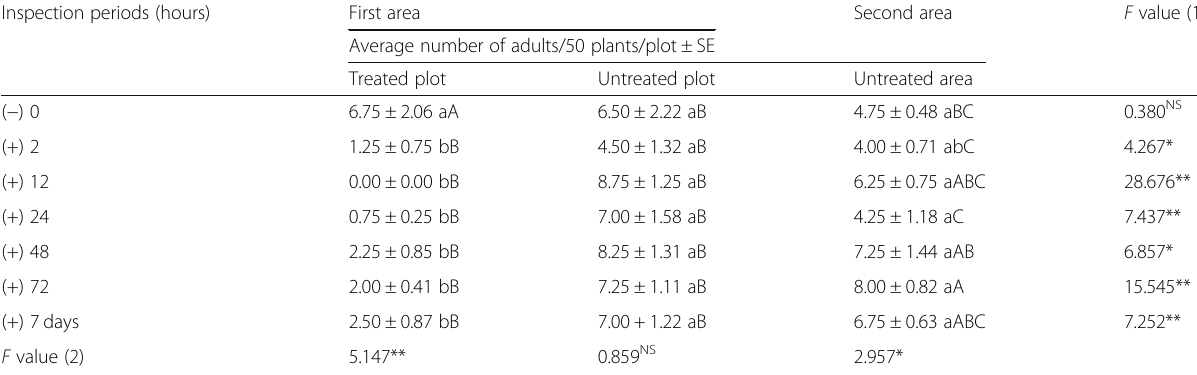
Table 3 Population densities of Stethorus punctellium adults in untreated and sulfur-treated marrow cultivations Inspection periods (hours)